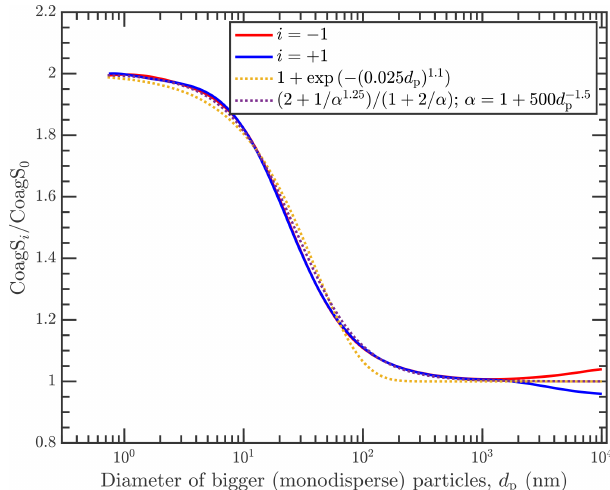
Figure 3. Coagulation sink ratios shown in Fig. 2, along with two parameterizations capturing the limiting